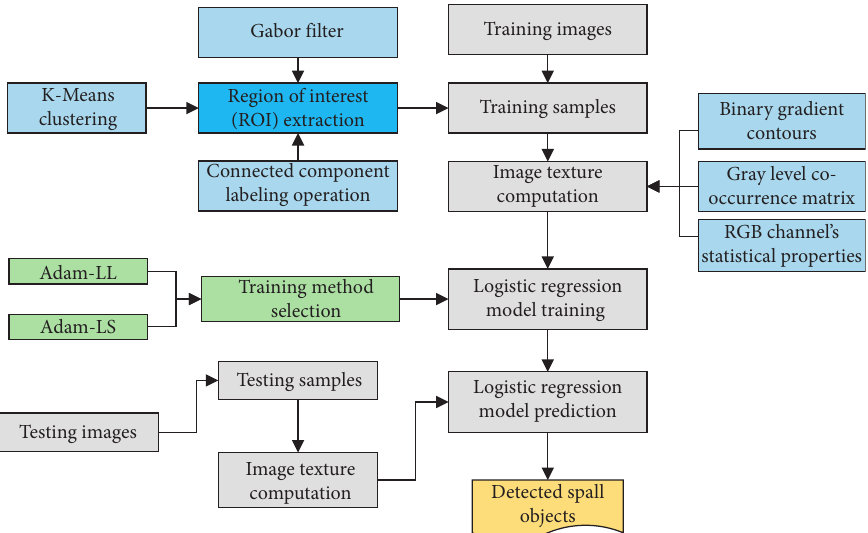
Figure 4: The proposed model structure.